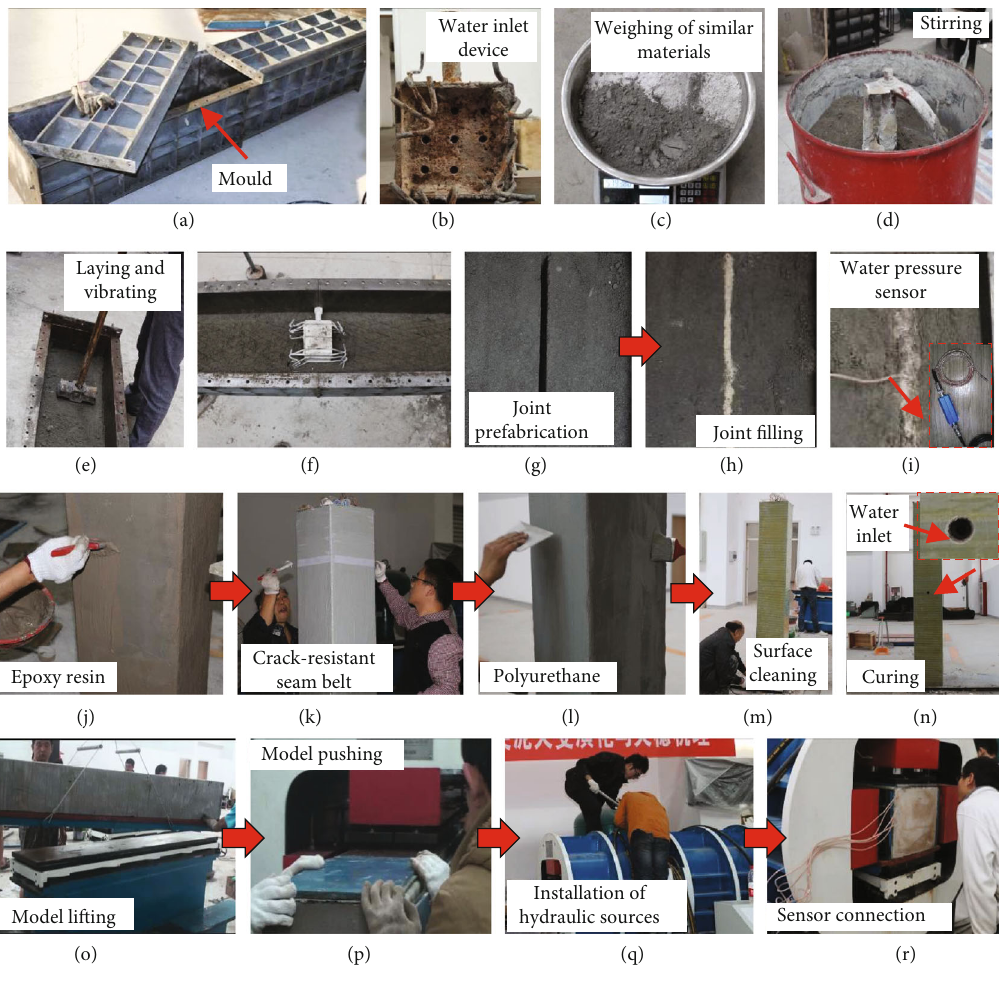
Figure 5: A typical process of model pouring, sealing, and